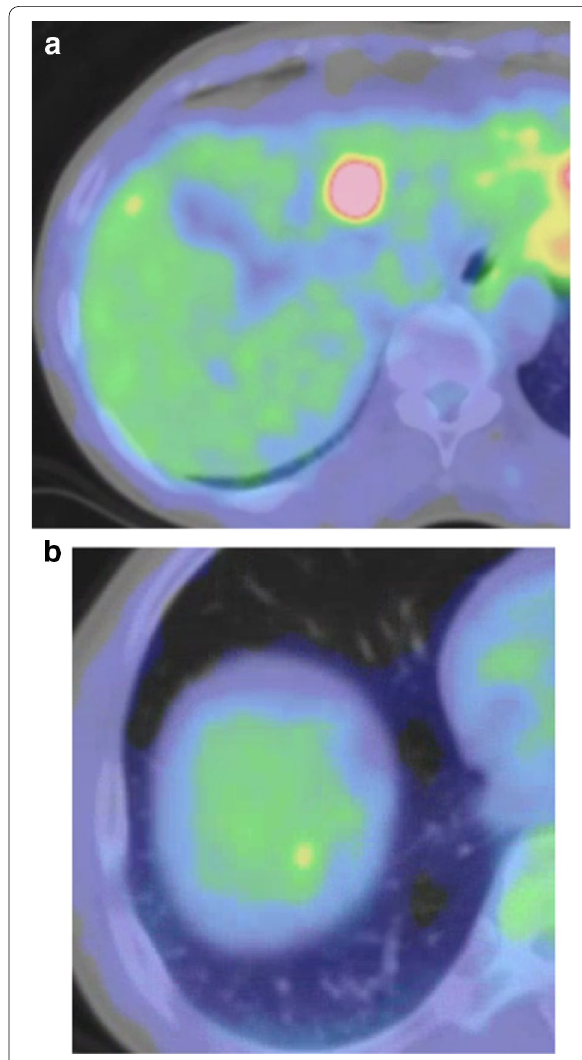
Fig. 2 Fluorine‑18‑fluorodeoxyglucose positron emission tomography (FDG‑PET) findings. a The segment III lesion appeared abnormal on FDG‑PET. b The segment VIII lesion did not show an abnormal